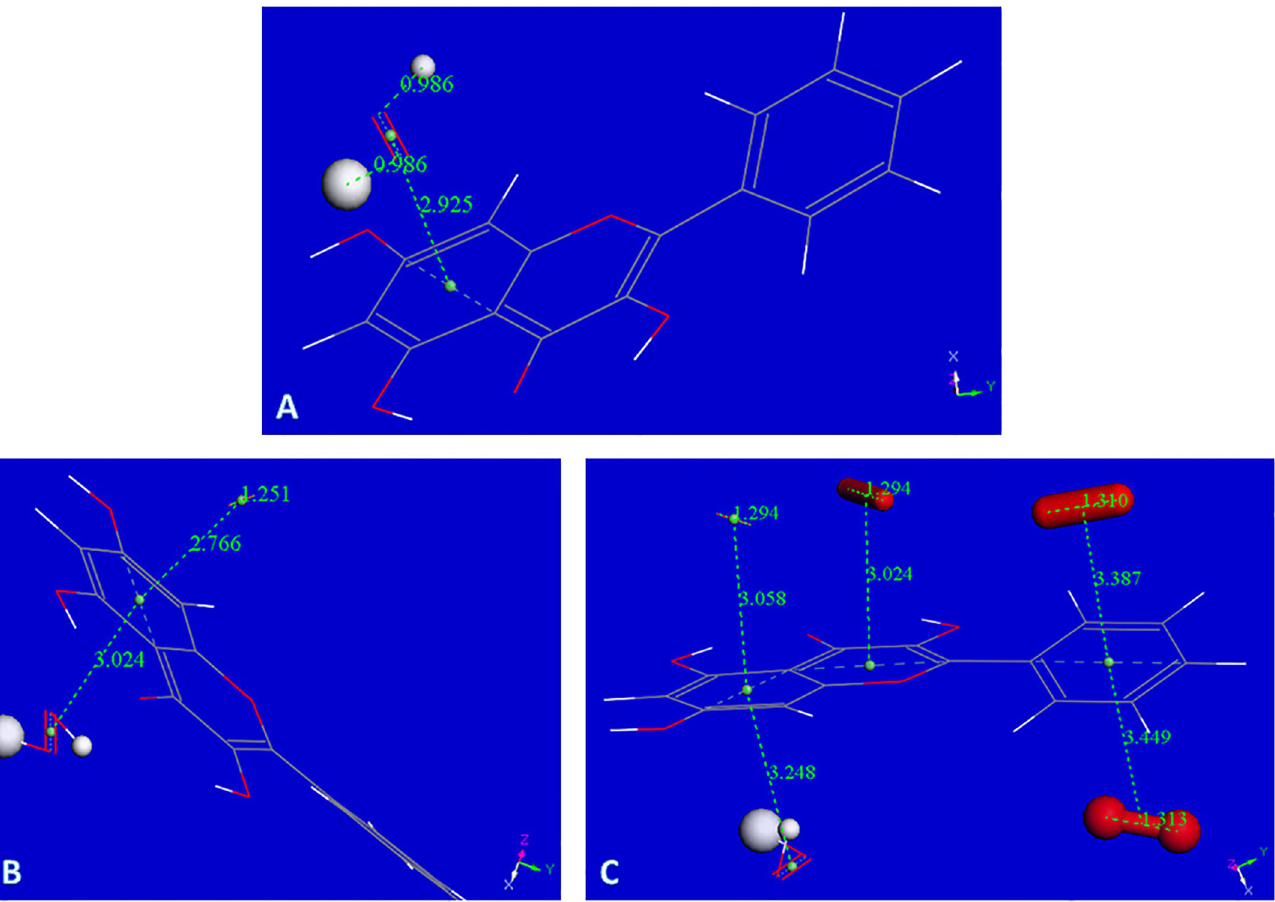
Fig 9. A: Minimum reached after excluding H 2 O 2 from Fig 8C. Total charge is still 2; B: Superoxide entering trans to H 2 O 2 moiety, total charge 1. This is a non- radical species and the O-O separation for the newly arrived superoxide, 1.251 Å , is much shorter than the original 1.373 Å , and similar to O-O bond length in O 2 ; C: After the arrangement shown in Fig 9B, three additional superoxide radicals are incorporated above and below the aromatic plane of galangin.